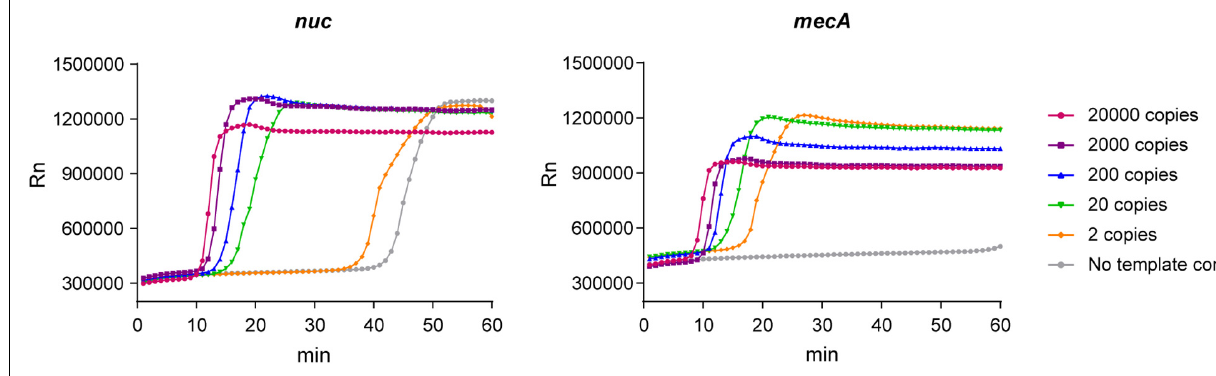
FIGURE 1 | Amplification curves of the real-time LAMP assay for nuc and mecA .